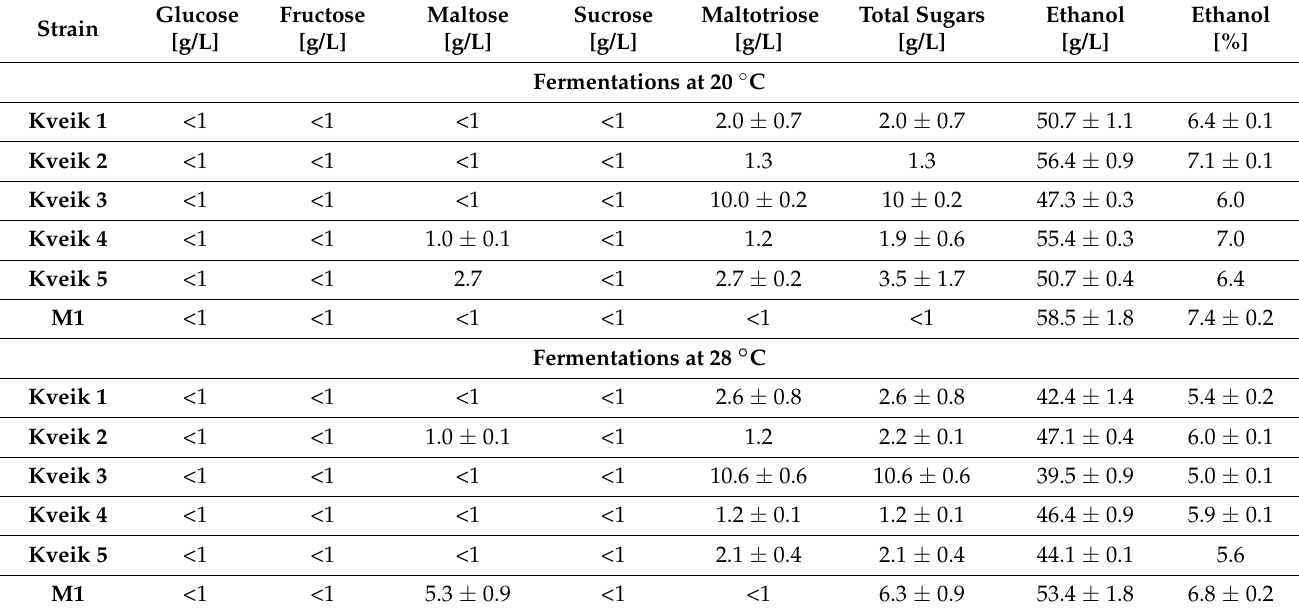
Table 4. Residual sugars and total ethanol